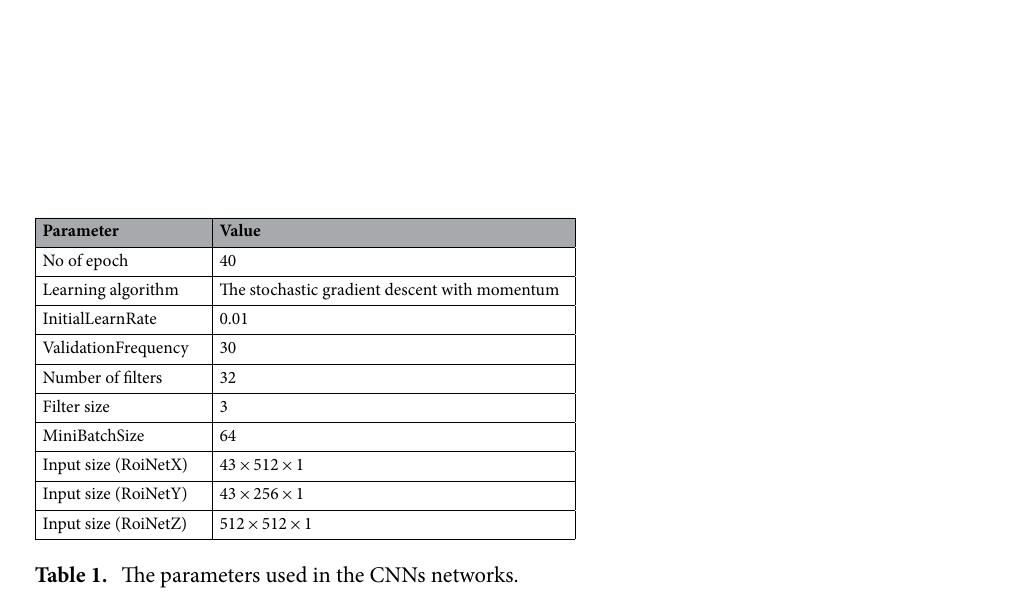
Figure 15. Example of region clustering algorithm. ( a ) Is the input image. ( b – h ) Are the automatically generated clusters. ( i ) Is the final computed kidney mask.